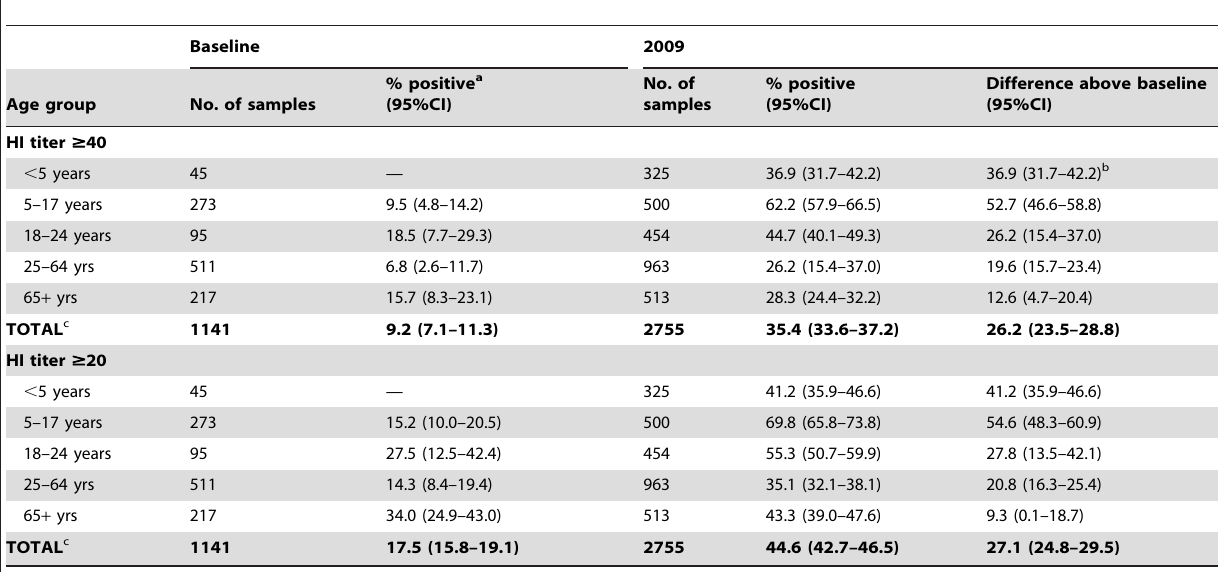
Table 1. Overall prevalence of seropositivity to A(H1N1)pdm09 at baseline and December 2009, by age